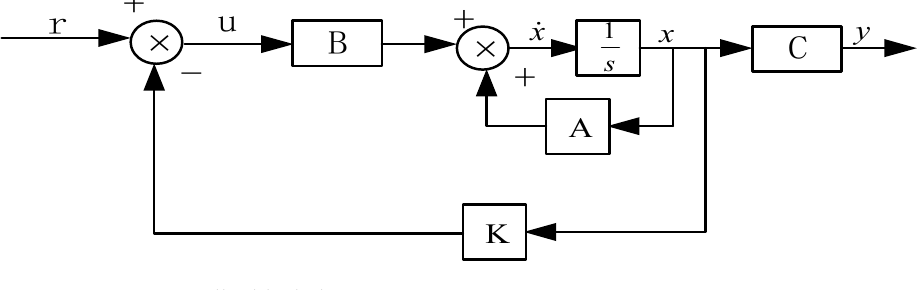
Figure 11. LQR controller block diagram.